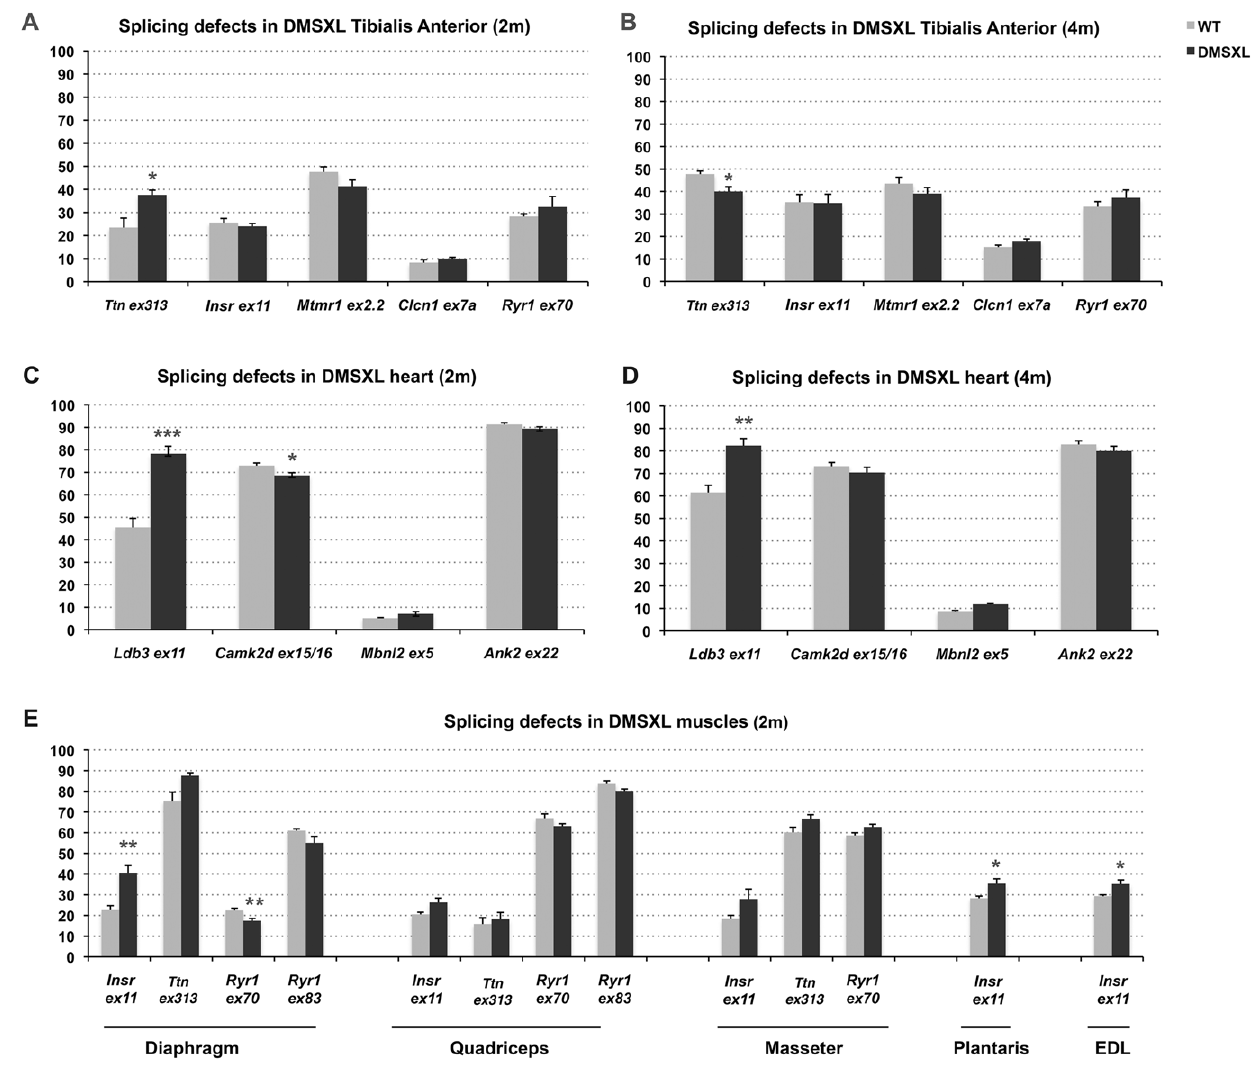
Figure 6. Splicing deregulation in DMSXL mice. Percentages of alternative exon inclusion in mRNA transcripts were studied by RT-PCR in 2- and 4-month-old mice in tibialis anterior (A–B) and heart (C–D), and in various muscles from 2-month-old mice (E). Results were compared between DMSXL (n=6) and WT (n=6). Each bar represents the mean of 6 biological replicates 6 SEM. Differences in percentage of alternative exon inclusion between DMSXL and WT mice were determined to be statistically significant by Student’s t test, * p , 0.05, ** p , 0.01, *** p , 0.001. 2 m, 2- month-old; 4 m, 4-month-old.